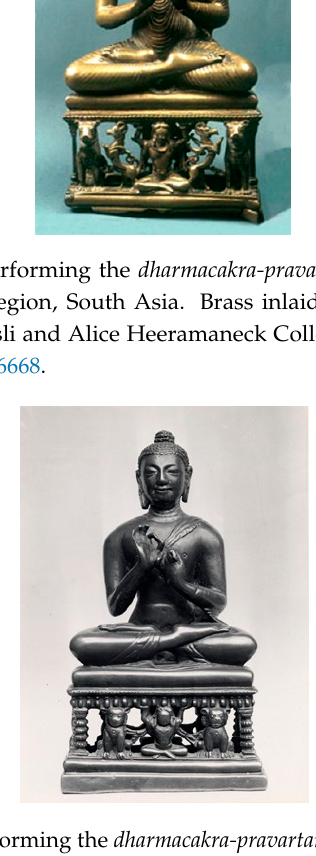
Figure 32. Vairocana Buddha performing the dharmacakra-pravartana mudr ā . Kashmir eighth c. Gilded bronze, British Museum (1953,0718.1) http://www.britishmuseum.org/research/collection_online/